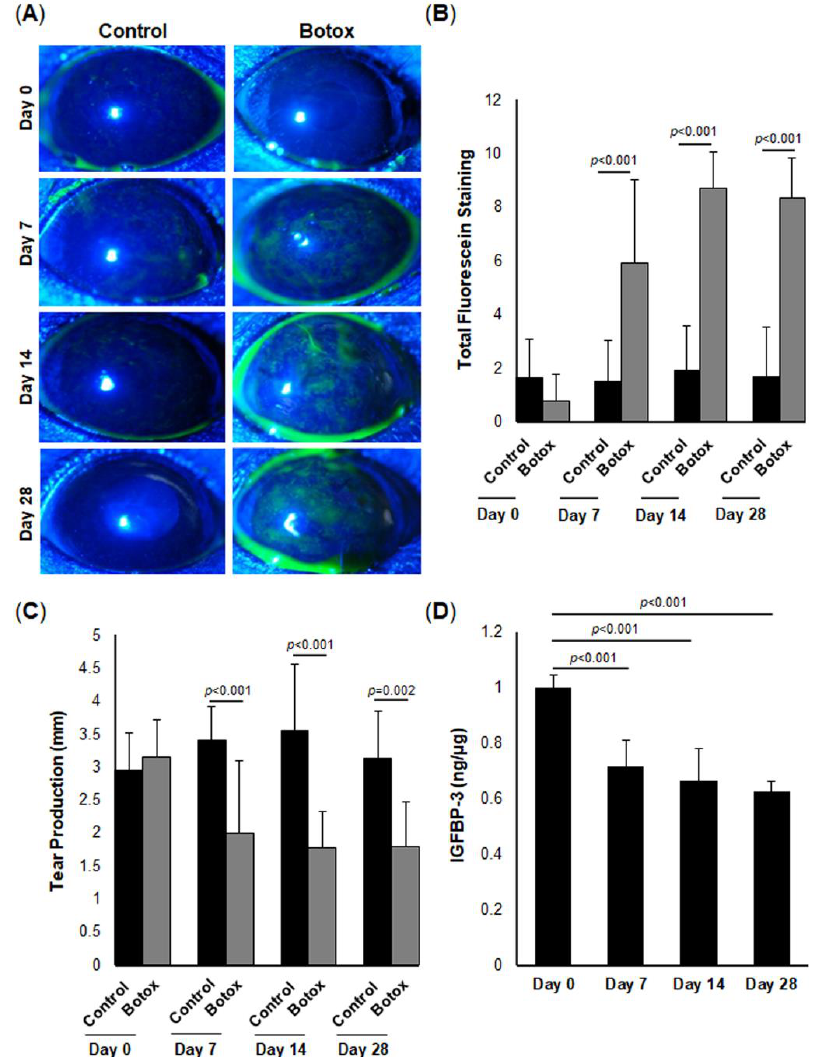
Figure 7. IGFBP-3 is decreased in the murine corneal epithelium in aqueous-deficient dry eye disease (DED). The lacrimal gland was injected with botulinum toxin or a vehicle control. Slit-lamp examination and phenol red thread test were performed at baseline, and then on days 7, 14, and 28 post-injection. ( A ) Slit-lamp examination showing corneal staining with fluorescein in mice using cobalt blue light. ( B ) Total corneal staining grade of all five quadrants (scale 0–3). No difference was evident at baseline ( n = 72). At all of the time points post-injection ( n = 58), the Botox-treated group exhibited more corneal staining compared to the vehicle control. ( C ) In the same group of mice, a phenol red thread test was used to measure tear production (mm). There was no difference between the test and control groups at day 0. Tear production was decreased 7 days post-injection and remained low at 28 days. ( D ) The expression level of IGFBP-3 in the mouse corneal epithelium was quantified using ELISA. By day 7, there was a measurable decrease in IGFBP-3 in the corneal epithelium that persisted at day 28 ( n = 9 per group, 3 corneas from 3 mice were pooled and used as biological replicates and tested on subsequent days). All pooled samples were run in triplicate. Data are presented as mean ± standard deviation, one-way ANOVA and SNK multiple comparison